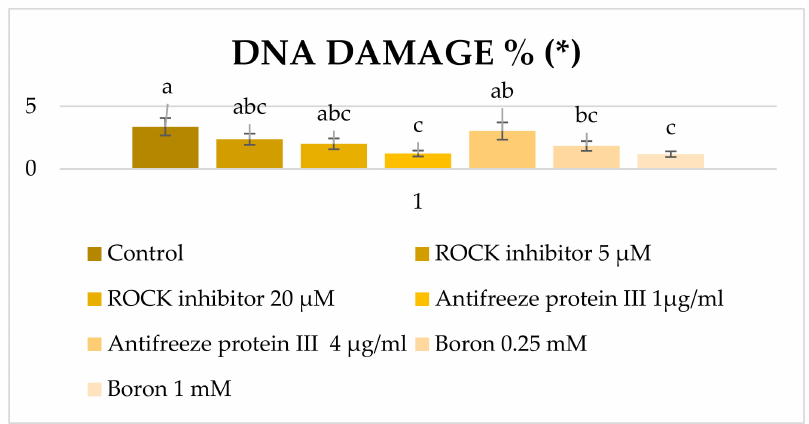
Figure 5. Findings of post-thawed DNA damage (%) of Ankara buck semen frozen with different additives ( ± SH). (*): The letters a, b, c in the same column represents the statistical differences ( p <